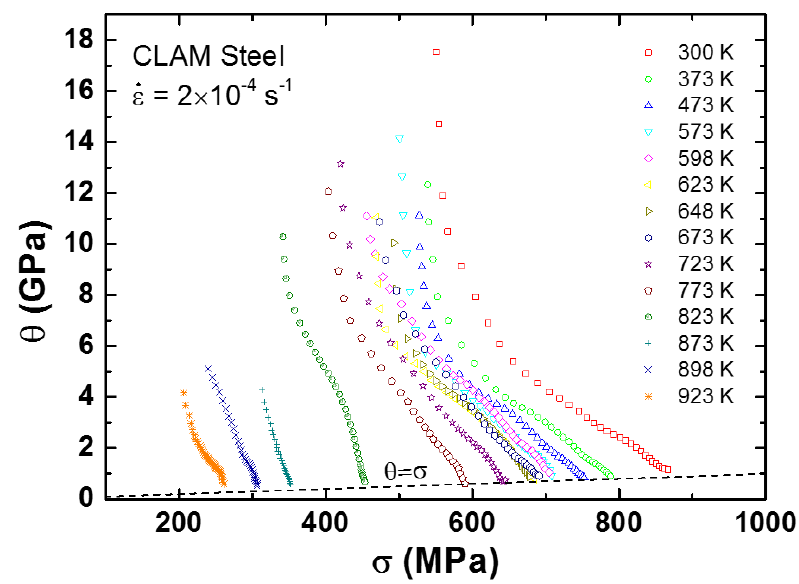
Figure 8. Variation of instantaneous work hardening rate ( θ ) as a function of true stress ( σ ) at different temperatures in China low activation martensitic (CLAM) steel.